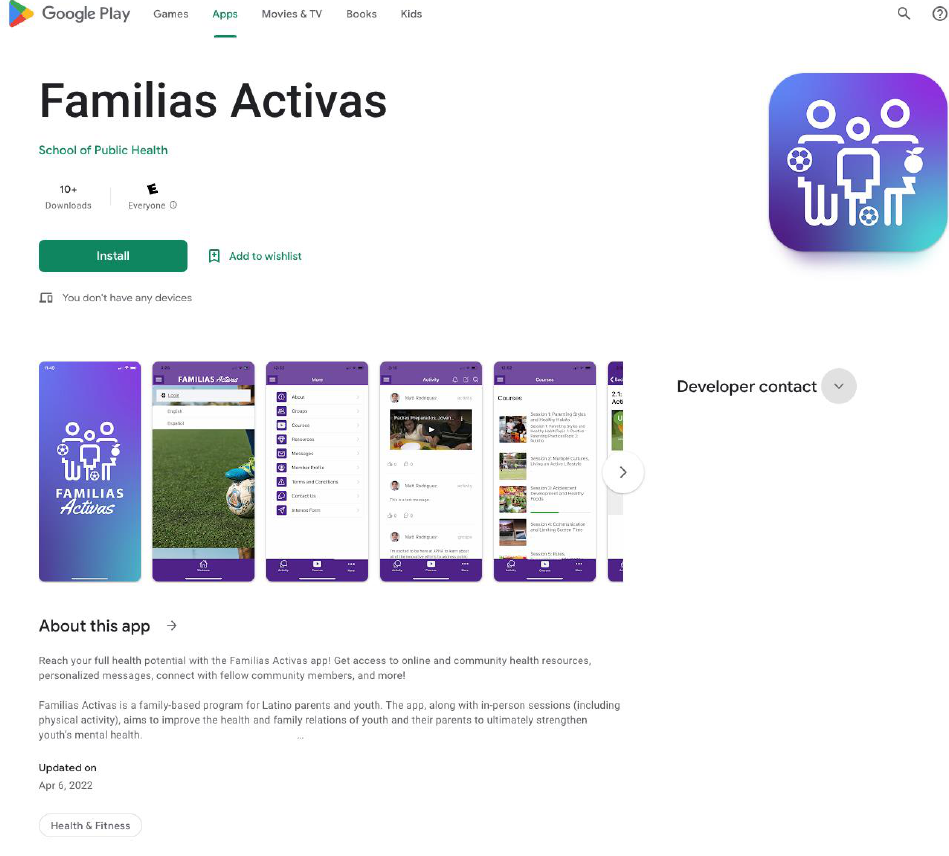
Figure 2. Familias Activas mobile health app (offered in both Google Play and iTunes).